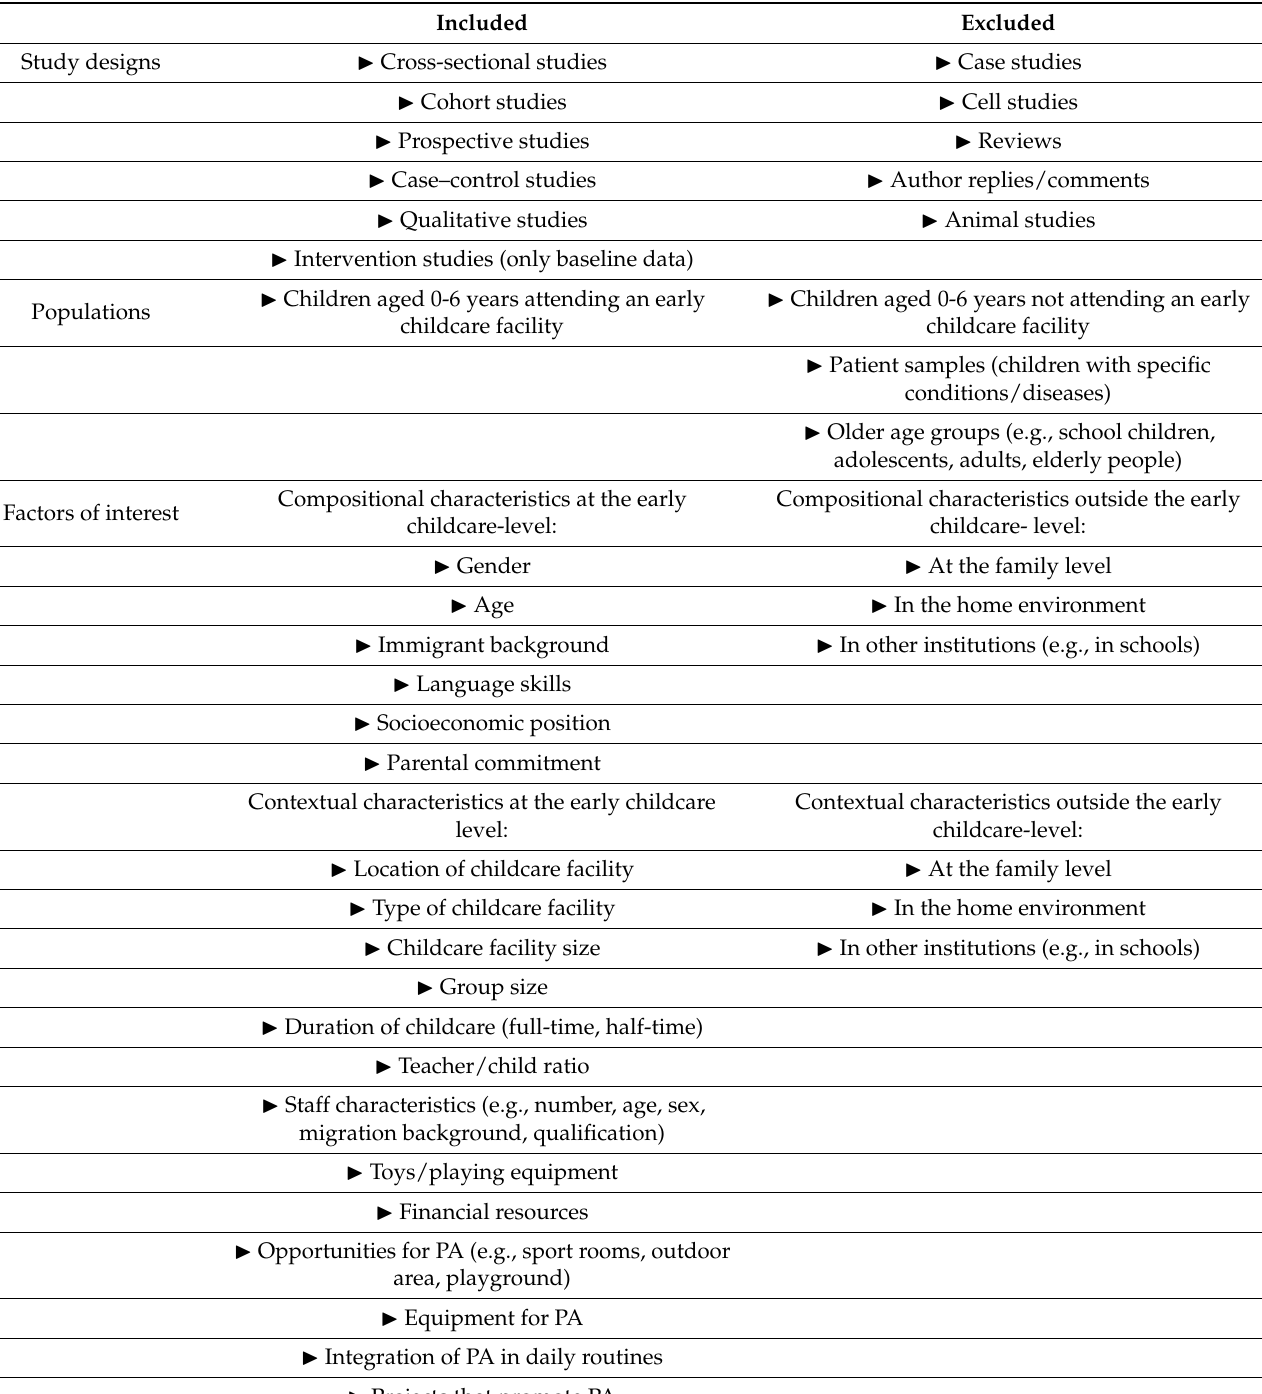
Table A1. Inclusion and exclusion